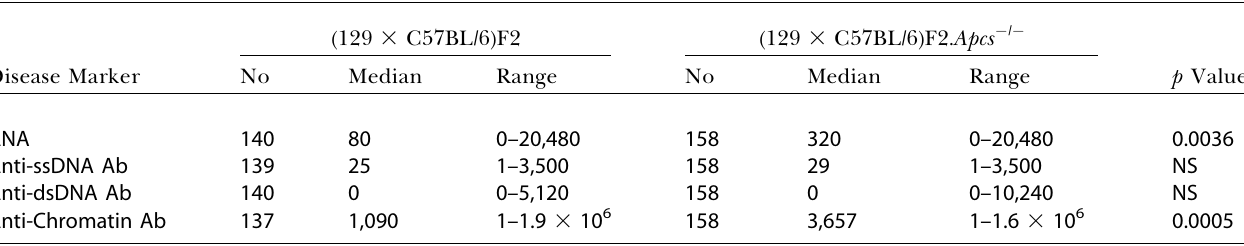
Table 1. Spontaneous Auto-Abs in Apcs (cid:1) / (cid:1) and Wild-Type (129 3 C57BL/6)F2 Female